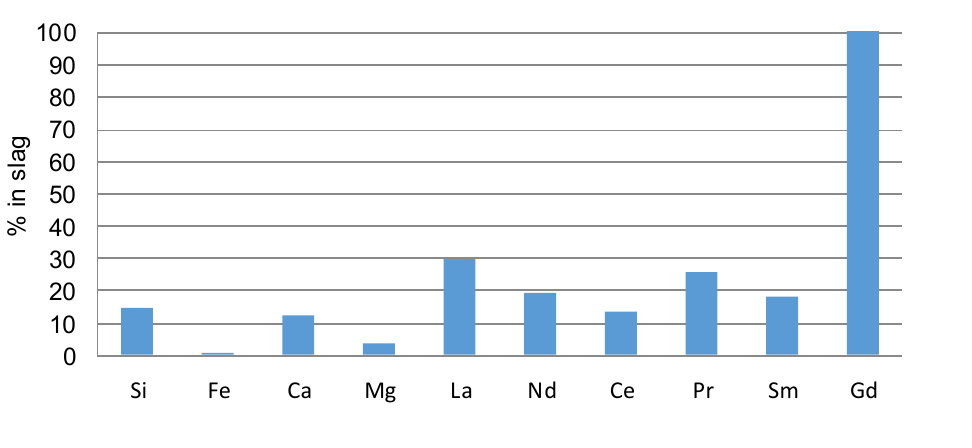
Figure 3 – Percentage of elements that have passed from bastnasite ore to slag Рис . 3 – Доля элементов , перешедших из бастнезита в